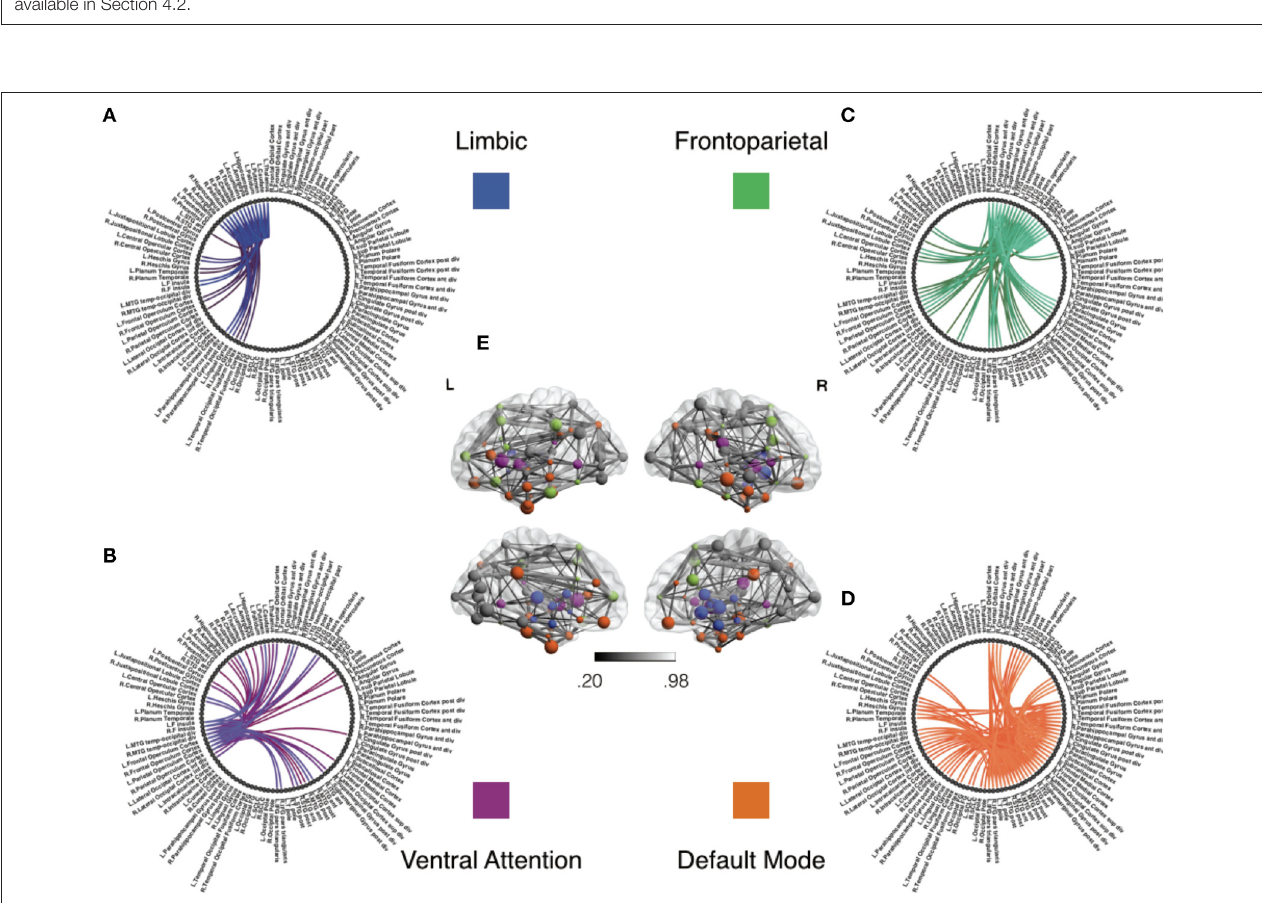
FIGURE 6 | Functional subnetworks of interest for covariate tests of network density. This figure illustrates the subnetworks we have chosen to test for covariate effects in Table 1 . Using previous studies discussed in Section 4.2, we seek to test whether symptom severity is associated with individual differences in the density or number of connections within and between these sub-networks. Panels (A–D) illustrate subnetwork components of the full group level network in panel (E) . The network structure in Panel (A) shows links within the limbic subnetwork as well as between the limbic regions and all other brain regions. Similarly, each of the other panels emphasize connectivity of fronto-parietal (B) , ventral attention (C) , and default mode (D) regions, respectively, to the whole brain. For the purposes of illustration, this group level network is obtained using individually estimated graphical models from the procedure in Section 2.3.1. Nodes correspond to anatomical regions in the Harvard Oxford Atlas (Fischl et al., 2004). The subnetworks correspond to resting state networks provided by Yeo et al. (2011). We first threshold weak edges with stability scores less than 0.8 in individual subject networks and then obtain a group level network by aggregating edge presence across all subjects. Note that we use this group network exclusively for illustrative purposes and not for statistical inference. The color gradient for edges in group network in panel (E) corresponds to proportion of stable edges found across all subjects.